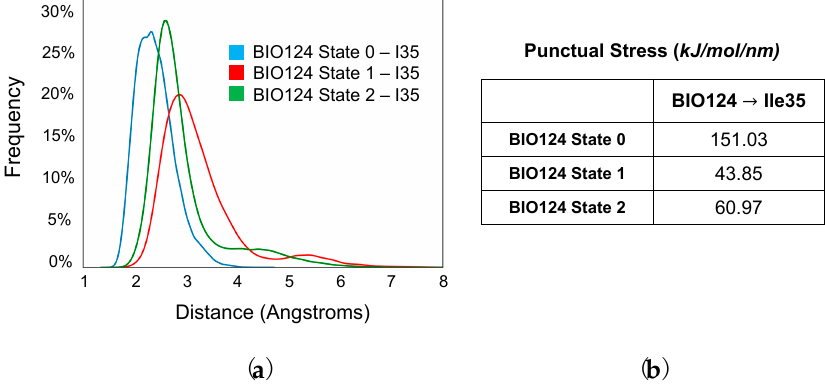
Figure 6. The role of I35 in inducing dynamic allosterism at the α A helix of the PICK PDZ domain. ( a ) Distance distribution between I35 of the PICK1 PDZ domain and BIO124 in each state. ( b ) Punctual stress on I35 of the PICK1 PDZ domain induced by BIO124 in each state.